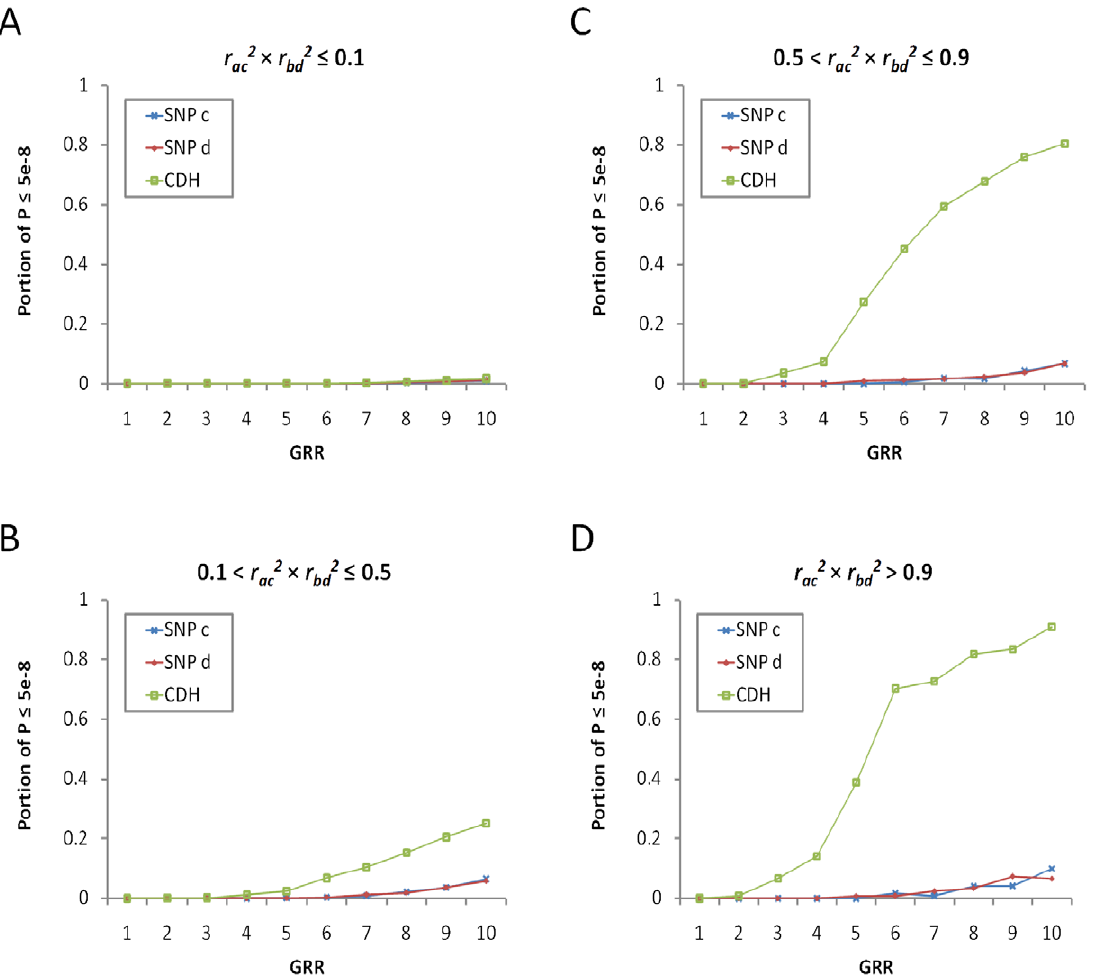
Figure 3. The power of CDH and single SNP analysis. Proportion of P values # 5 6 10 2 8 from the CDH analysis (green dots) and the single SNP Cochran-Armitage test of two tagging SNPs c (red dots) and d (blue dots). Four SNPs were re-sampled 10,000 times from the Illumina 550 K chip. SNPs a and b were physically close ( , 200 kb) and had low MAFs ( , 5%). SNP c was in LD with a and SNP d was in LD with b . The genotypic relative risk was simulated according to the genotypes of a and b under the recessive and compound heterozygote model, where GRR AA = GRR BB = GRR AaBb . The base-line prevalence of a binary phenotype was fixed at 5%. A, when r ac2 6 r bd2 # 0.1; B, when 0.1 , r ac2 6 r bd2 # 0.5; C, when 0.5 , r ac2 6 r bd2 # 0.9, and D, when r ac2 6 r bd2 .